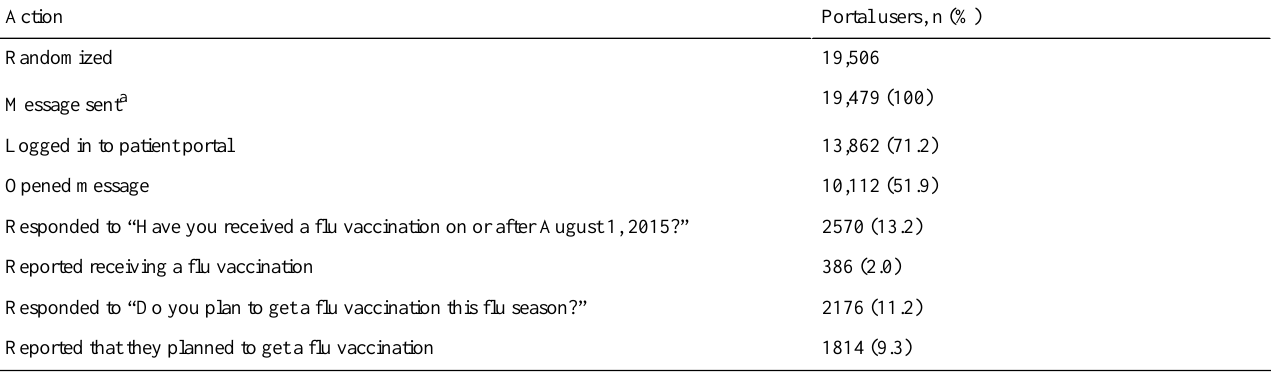
Table 3. Process measures and self-reported influenza vaccinations for portal message